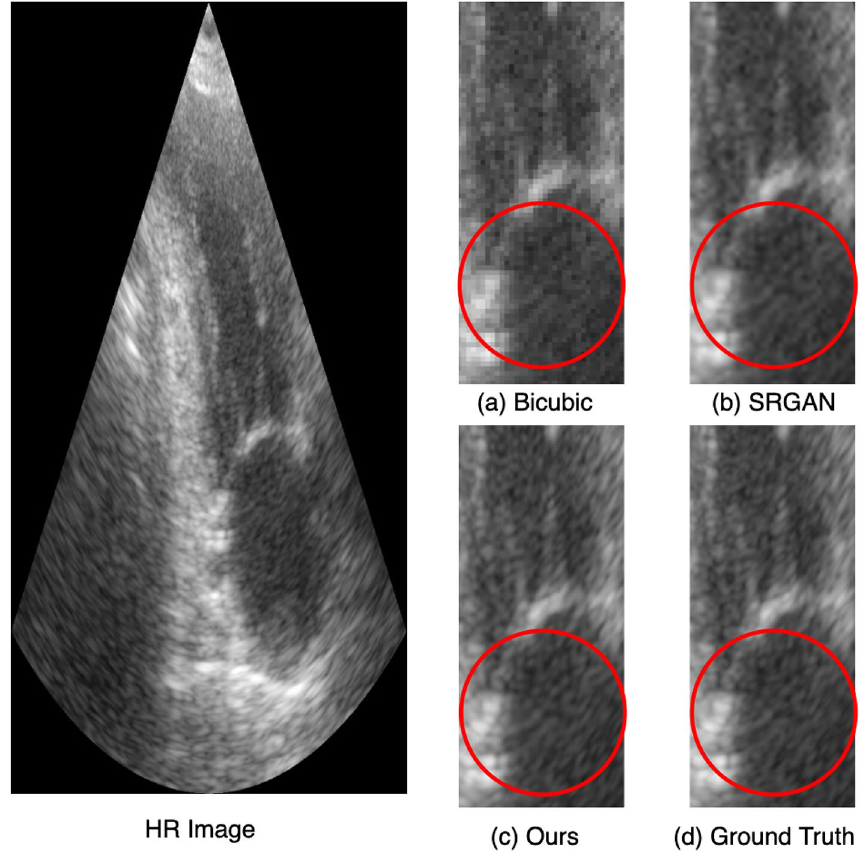
Figure 13. Small region results on cardiac ultrasound image. The sub-region for ( a ) Bicubic interpolation. ( b ) SRGAN 31 . ( c ) Proposed architecture. ( d ) Ground truth HR image.